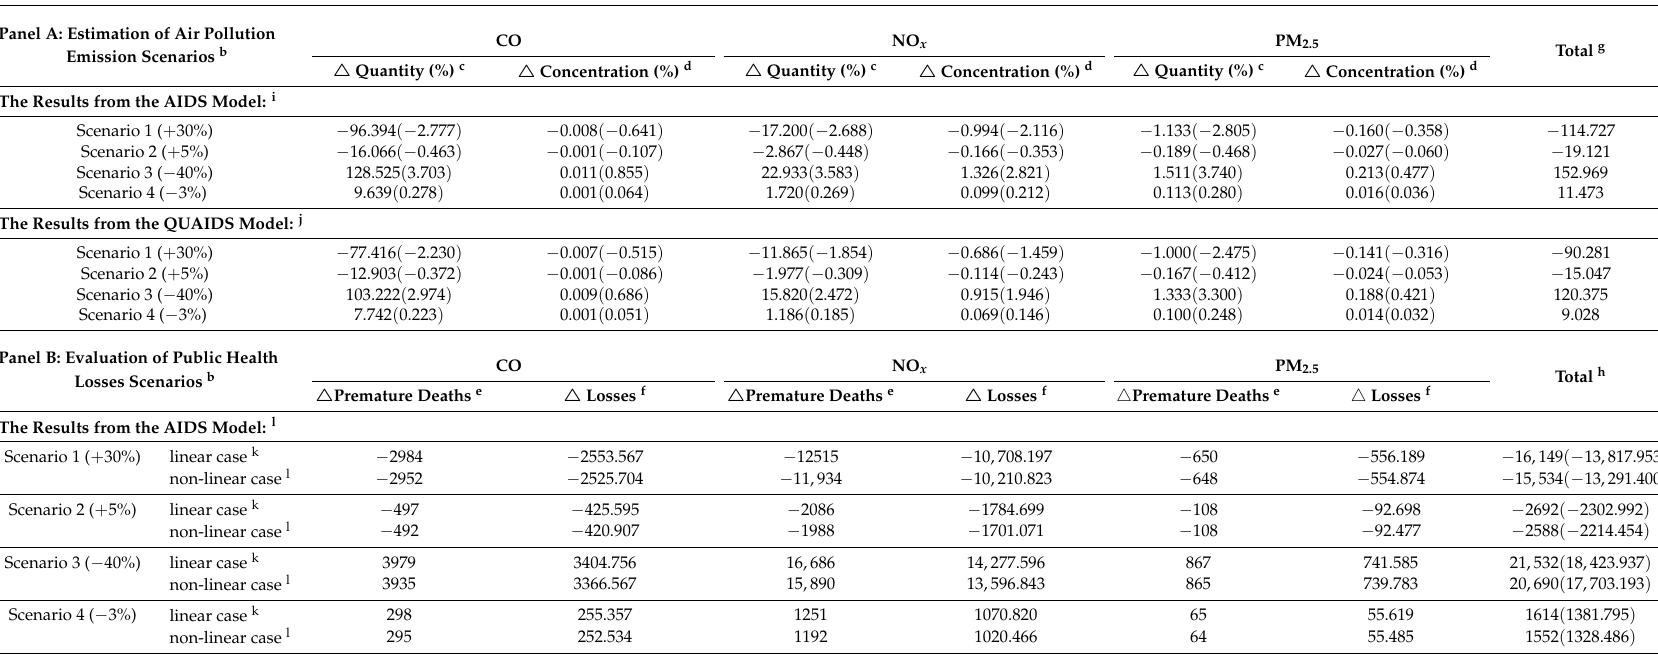
Table 6. Air pollution emissions and public health losses from the road transport sector a